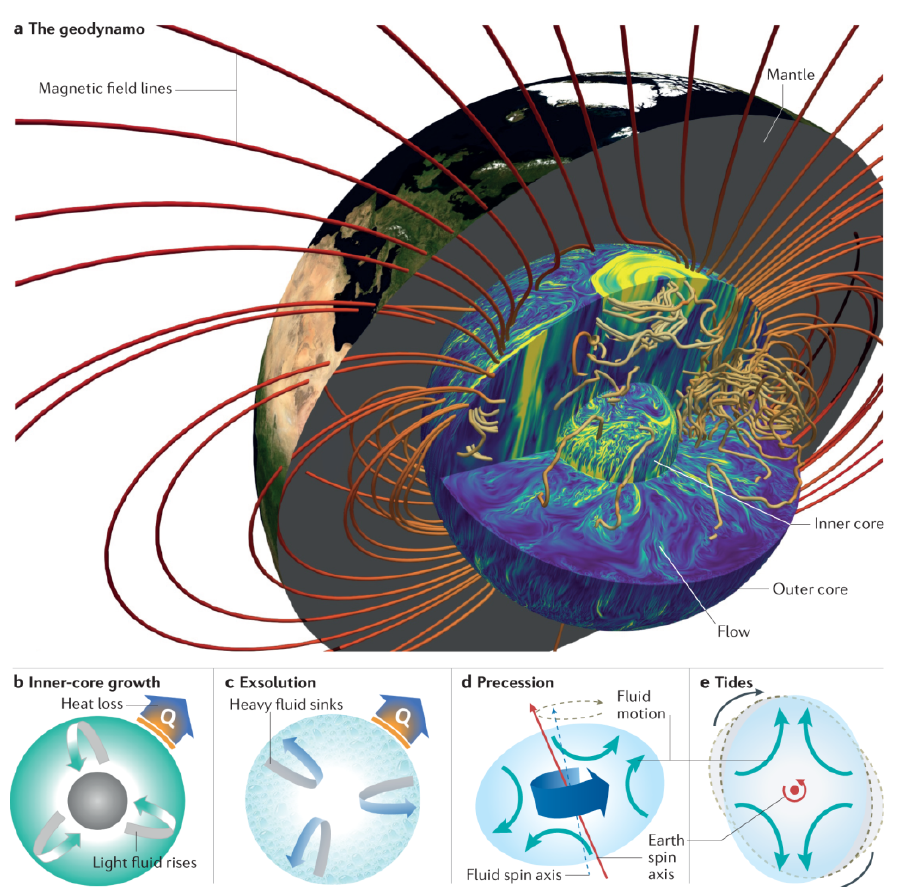
Figure 15. ( a ) The three-layer structure of Earth’s interior. The rocky mantle overlies a metallic core. The core, which is essentially made of iron, is divided into a liquid outer core and a solid inner core. The flow of liquid metal sustains dynamo action. The magnetic field lines (red to yellow lines) and the velocity field strength (blue to yellow) are taken from a direct numerical simulation of the dynamo driven by turbulent convection. ( b – e ) Candidate mechanisms that may drive the geodynamo in the outer core. ( b ) Convection driven by core cooling and inner-core growth. The heat Qcmb leaving the core leads to the solidification of the inner core, releasing light elements at the base of the outer core. At the outer edge of the core, cooling releases a cool, denser fluid that sinks into the deeper core. ( c ) Convection driven by the exsolution of light oxides such as MgO or SiO 2 . The iron-rich liquid released at the top of the core sinks into the core. ( d ) Precession makes the fluid rotate along an axis (blue) that is different from the mantle rotation axis (red); a secondary circulation (teal arrows) is induced by the non-spherical shape. ( e ) Tides induce a deformation that rotates around the liquid core over approximately one day, inducing a recirculation. (Adapted with permission from Ref. [53], 2022, M. Landeau.)